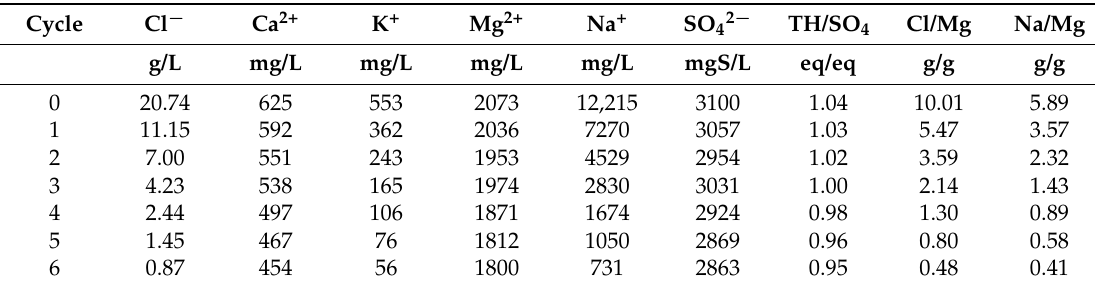
Table 6. Results of applying six DiaNF counter current cycles on the retentate obtained in the dense UF step (GH 80% RR). Operational conditions: Pressure: 15 bar; diluent: Distilled water (last three cycles) and DiaNF permeate (first three cycles); temperature 20 ± 2 ◦